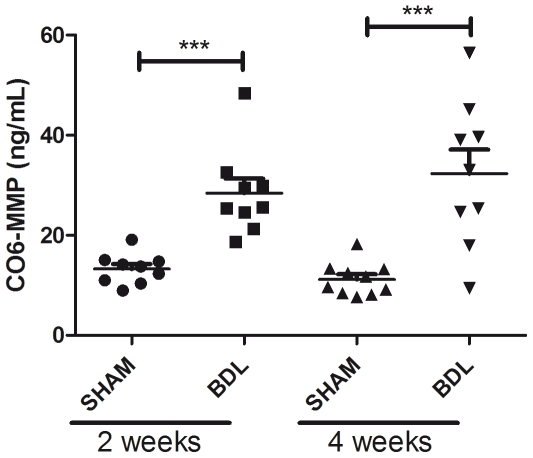
CO6-MMP serum levels in BDL-rats.BDL rat liver fibrosis model. Serum CO6-MMP was assessed in BDL and sham operated rats at termination. Termination time points were 2 and 4 weeks after surgery. Levels of CO6-MMP were significantly elevated in BDL rats compared to sham levels at both the two-( mean BDL 29.5 ng/mL, mean sham: 14.2 ng/mL, p = 0.0001) and four week mean BDL: 33.0 ng/ml, (mean sham: 11.8 ng/mL, p = 0.0003) termination point.